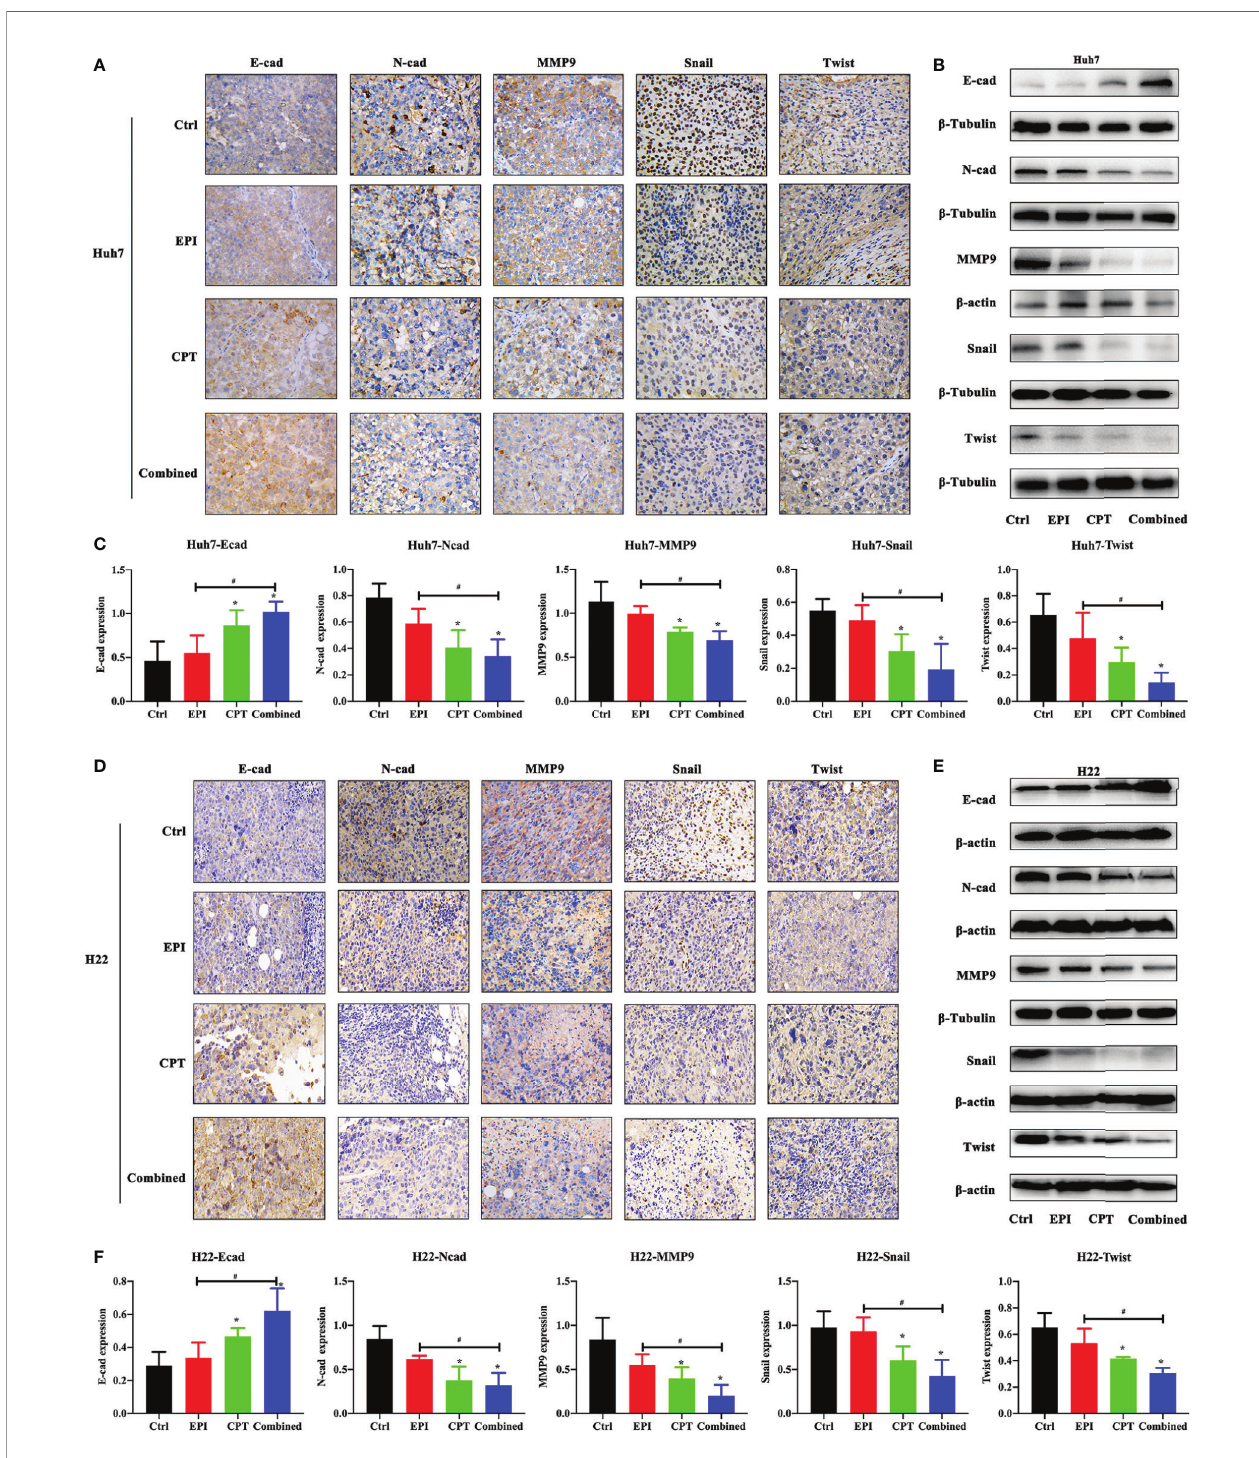
FIGURE 5 | CPT suppressed EMT progress of subcutaneous xenotransplanted Huh7 and H22 tumors. The EMT progress assay was performed by subcutaneous xenotransplanted Huh7 and H22 tumors. (A, B) The expression of E-cadherin (E-cad), N-cadherin (N-cad), MMP9, Snail and Twist was measured by immunohistochemical staining (A) , and western blot (B) in Huh7 tumor. (C) Densitometry assay of the band in western blot in Huh7 tumor. (D – F) The expression of E-cadherin (E-cad), N-cadherin (N-cad), MMP9, Snail and Twist was measured by immunohistochemical staining (D) , and western blot (E) in H22 tumor. (F) Densitometry assay of the band in western blot in H22 tumor. ß -actin and ß -Tubulin were the internal reference. *P < 0.05, # P <